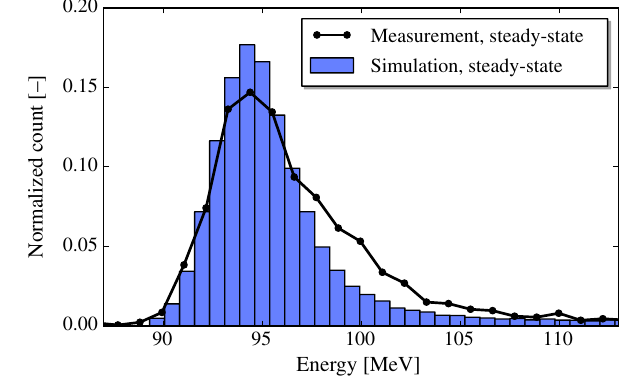
FIG. 6. Measured energy spectrum along the pulse at the end of the TBL for a beam current of 13.5 A. The contour lines show 10% increments of the maximum value of the signal, and the energy changes slightly along the pulse. The star shows the point with the most decelerated particles, while the crosses show the mean energies.